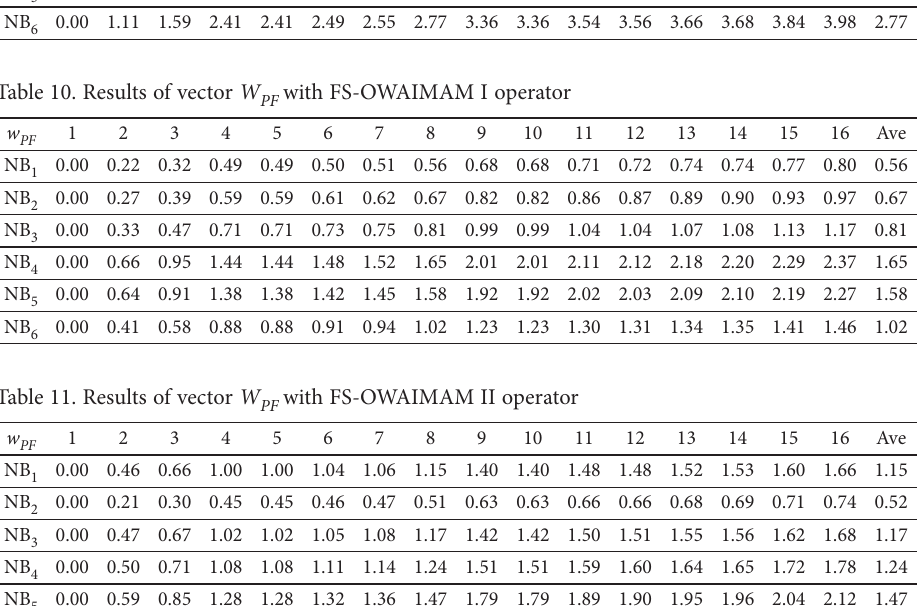
Table 10. Results of vector W